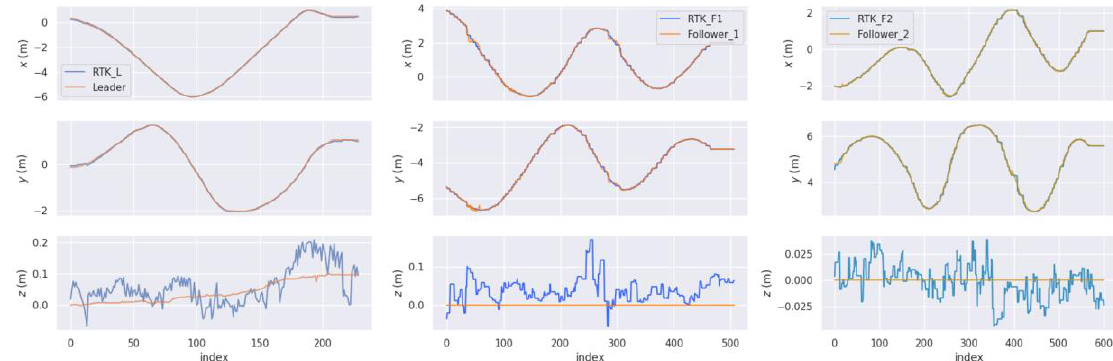
Figure 9. The trajectory of the AGVs group on the axes, in which the Followers’ Z-axis data is normalized to 0 .